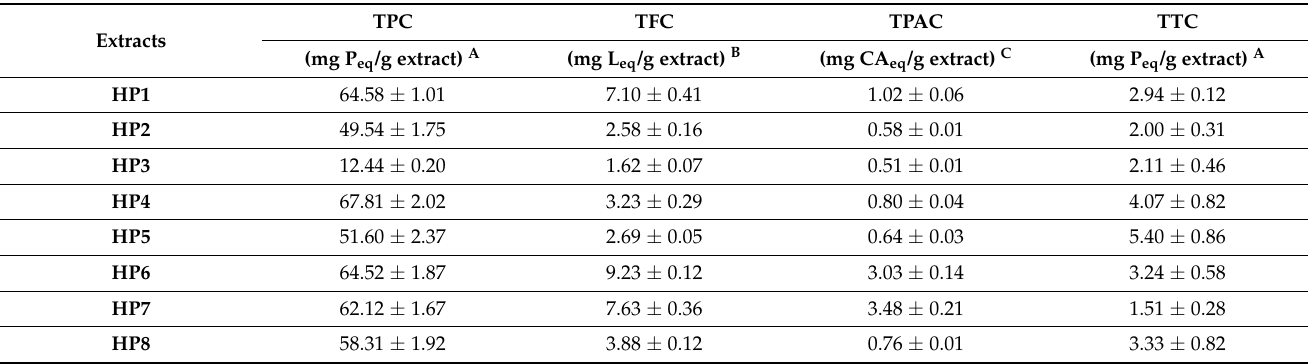
Table 3. Phytochemical analysis of the total phenolic (TPC), total flavonoid (TFC), phenolic acid (TPAC), and tannin contents (TTC) of HP1 – HP8